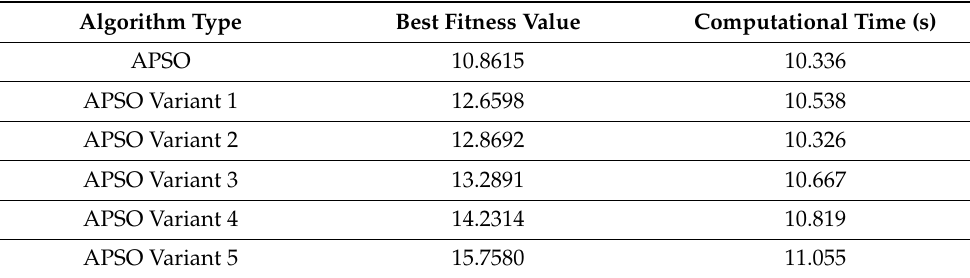
Table 3. Summarized results of APSO and its variants for 50 PHEVs.